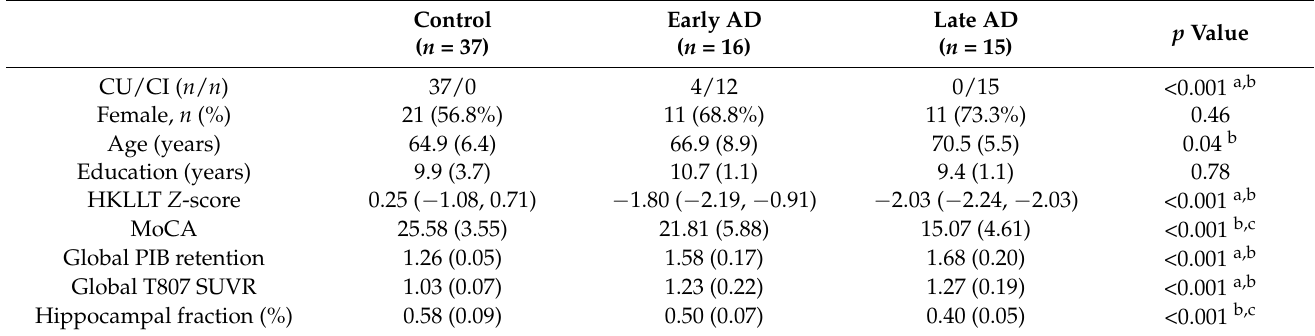
Table 1. Demographic characteristics and imaging data of controls, early AD and late AD